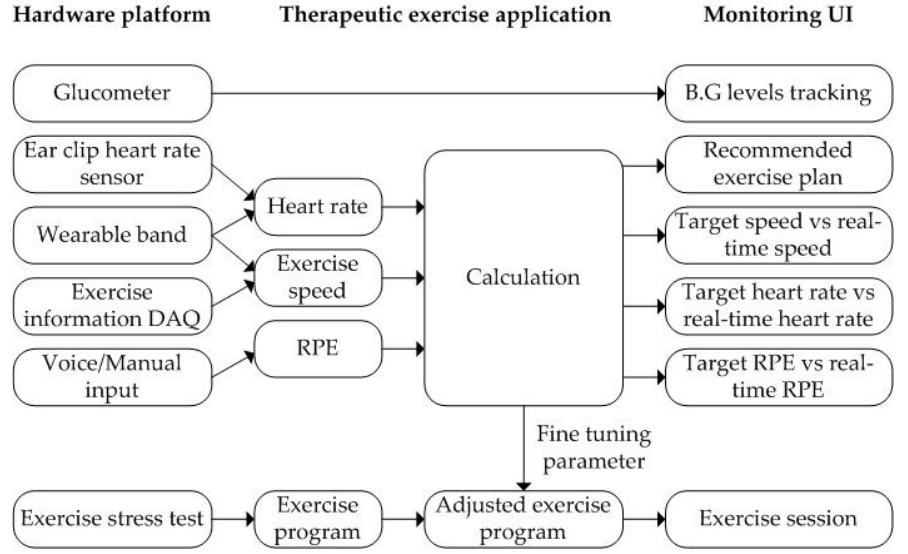
Figure 8. The proposed therapeutic exercise platform for an exercise coaching program.